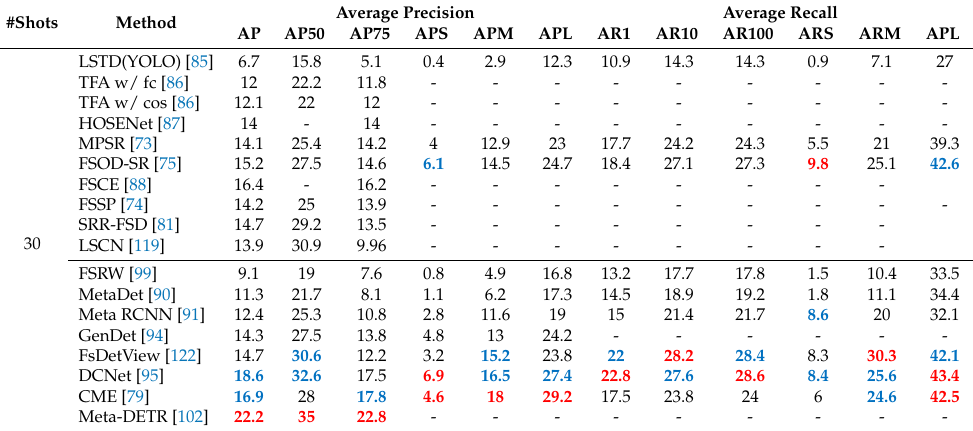
Table A4. Few-shot detection performance (AP (%) and AR (%)) of novel classes on the COCO dataset when 30-shot . Red, and blue indicate the state-of-the-art and the second-best, respectively. Average Precision Average Recall #Shots Method